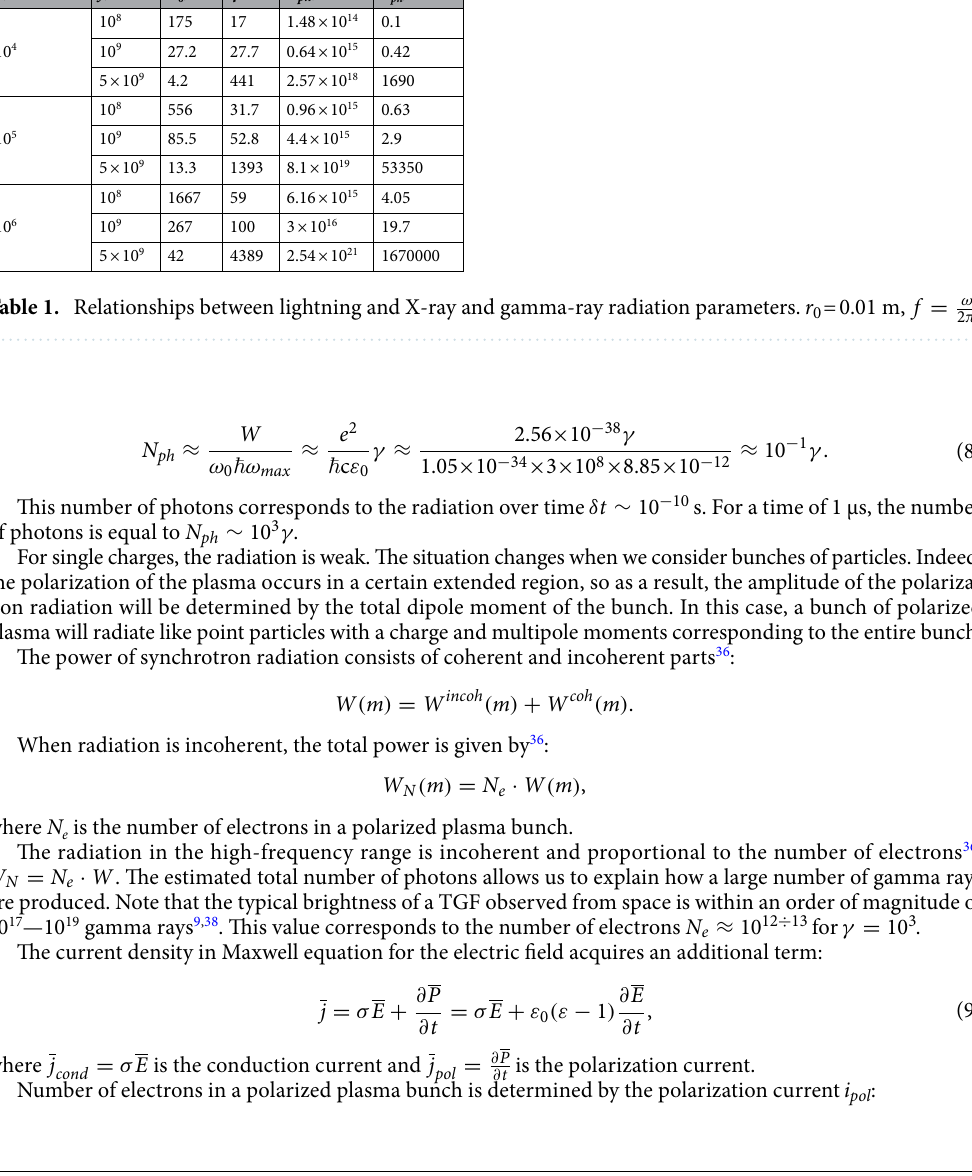
Figure 11. The photon frequency and energy as function of conductivity. ω σ , Ω −1 m